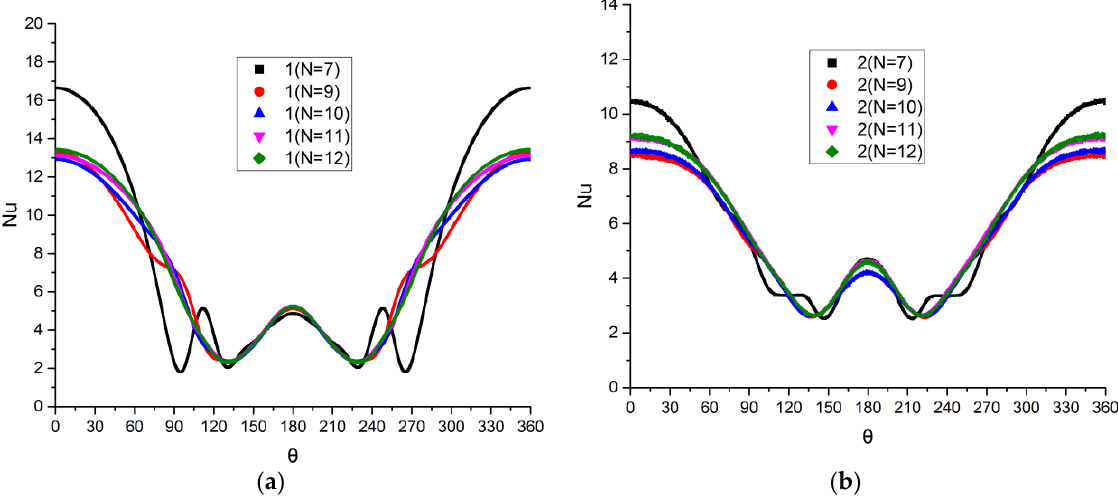
Figure 3. Convergence test with different orders of the Legendre polynomial (N), the Nusselt number on the surface of a regular two-cylinder tandem array with distance ratio, L/D = 5, Re = 200: ( a ) upstream cylinder; ( b ) downstream cylinder.